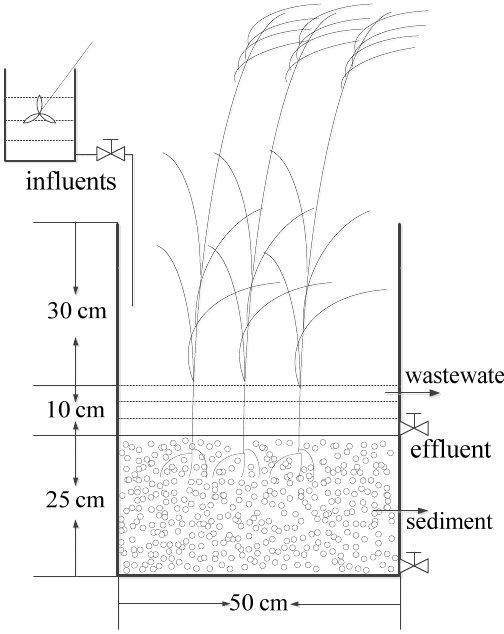
Figure 1. Schematic of the wetland